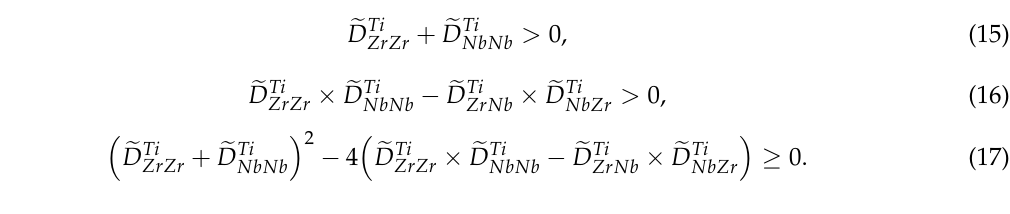
Table 2. Inter-diffusion coefficients in the bcc Ti-Mo-Zr alloys at 1373 K and 1473 K. Temp.